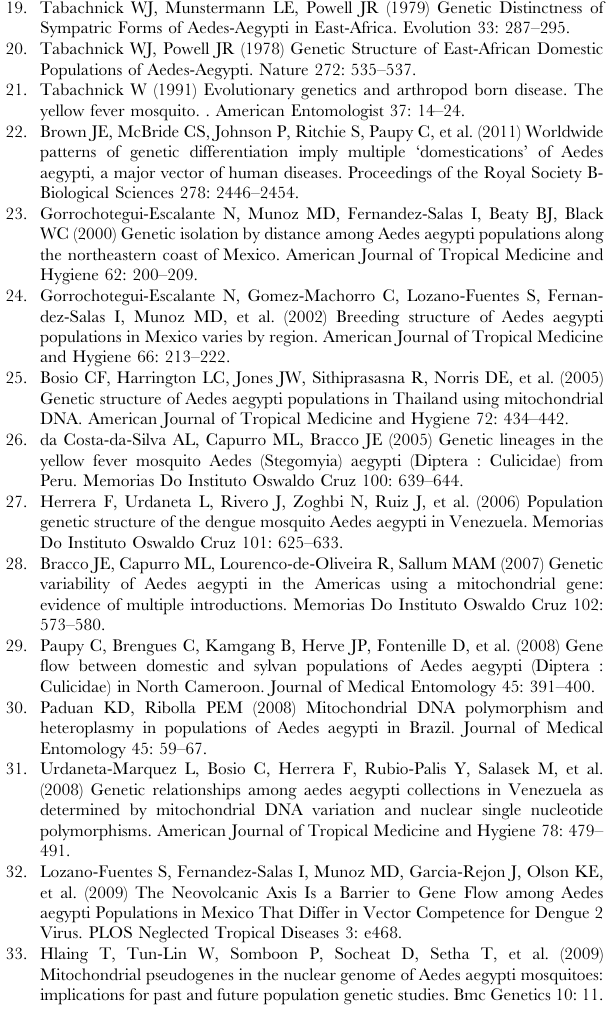
Table S1 Unique mitochondrial ND4 sequences in GenBank (117 total) listed according to the order of appearance in the literature or in GenBank. The third column contains the GenBank # for entries with identical sequences to the initial submission. There are 214 entries (rows) in the table. The 4 th column indicates whether the haplotype occurs in the basal (B) or the derived (D) clade. The name of the haplotype as it appears in the original publication (column 7) is listed in the 5 th columns and the collection location in the 6 th